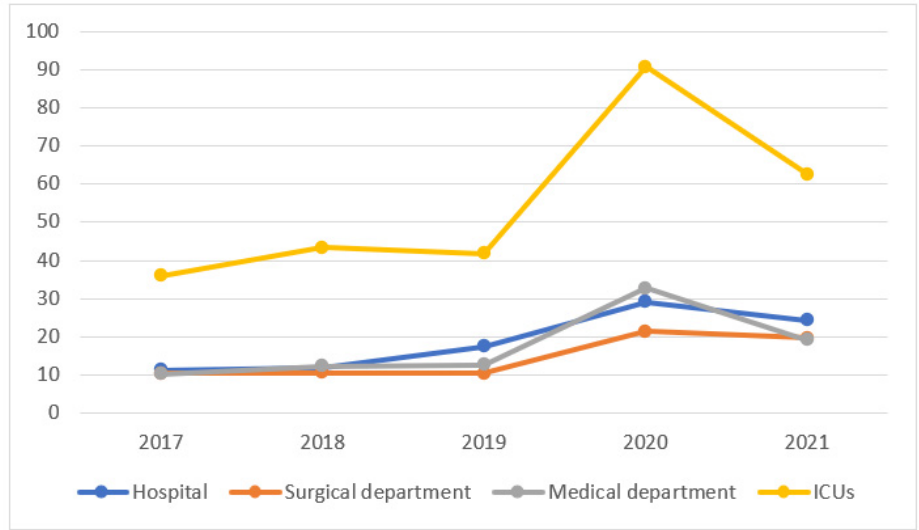
Figure 1. Median alcohol-based handrub consumption (AHC, liters/1000 patient-days) among 27 hospitals in Piedmont, 2017–2021.